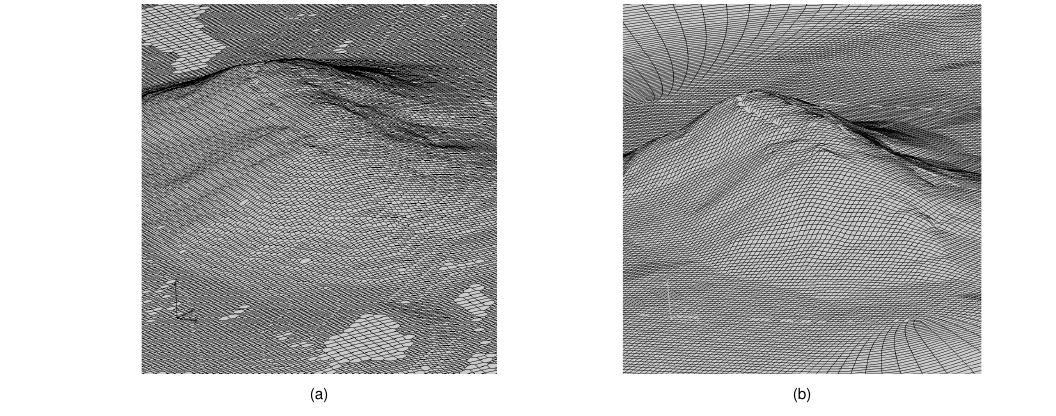
Figure 1. Askervein Hill: surface grid generated with (a) SnappyHexMesh and (b) surfgrid.